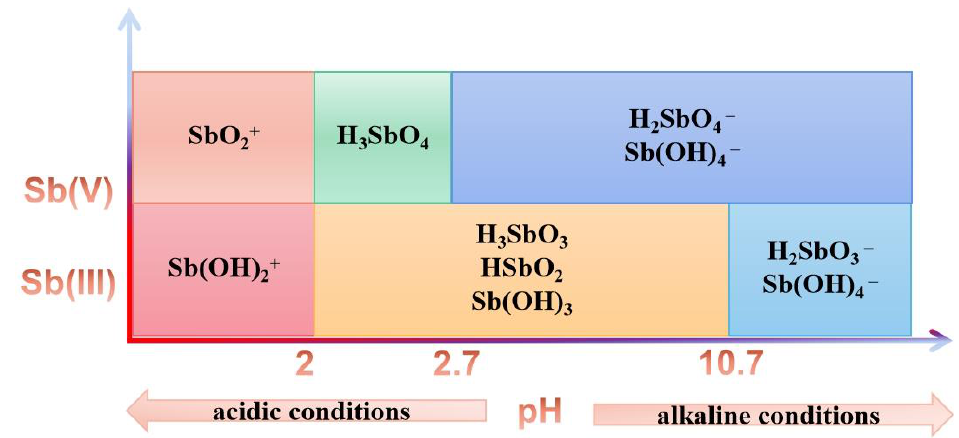
Figure 3. Chemical forms of Sb at different pH values [45].